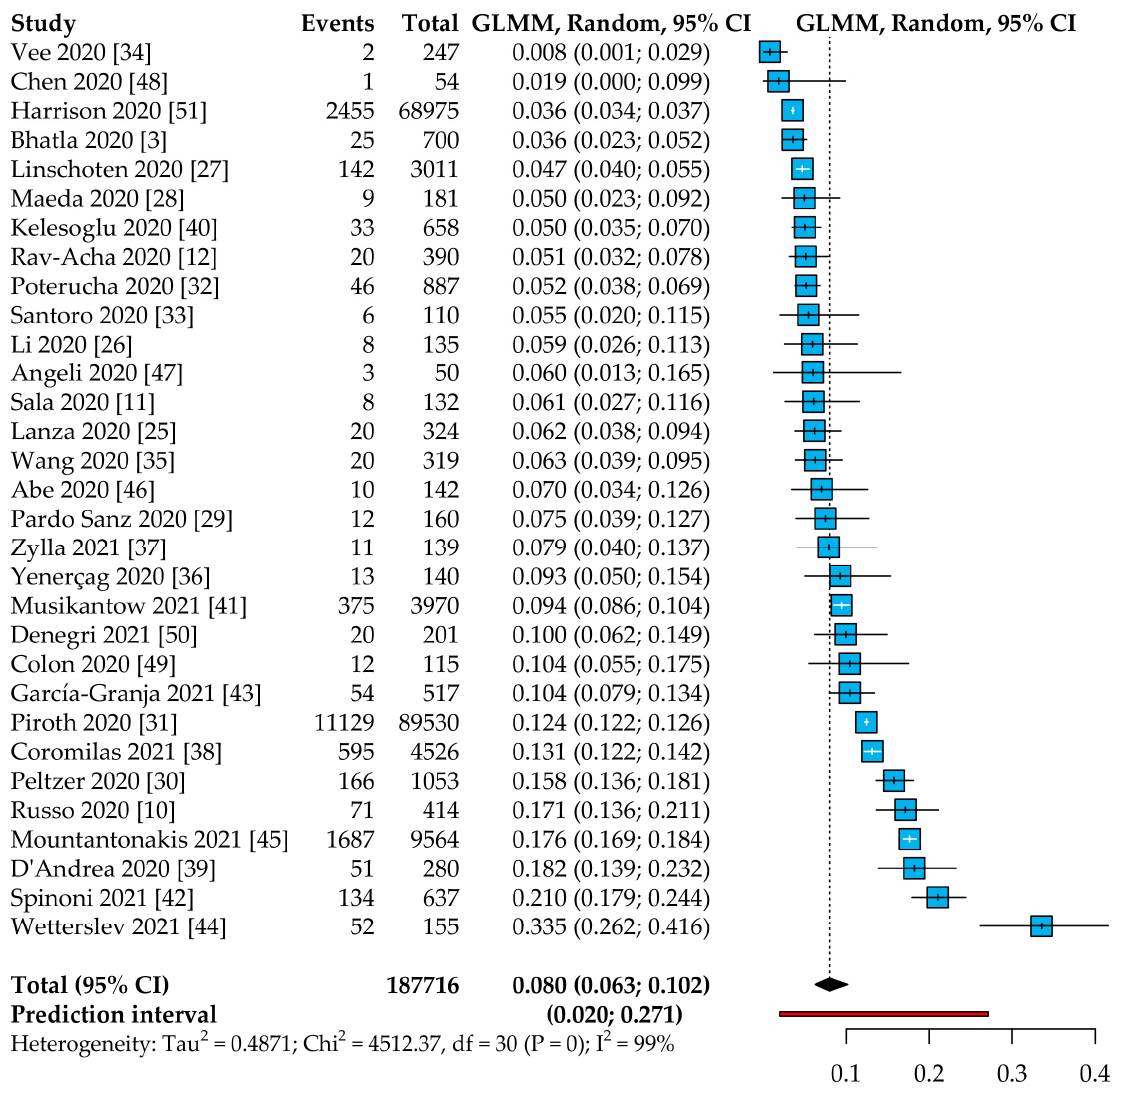
Figure 1. Pooled prevalence of AF in COVID-19 patients. Legend: CI = confidence interval; GLMM = general linear mixed model. Table 2. Univariable and multiple meta-regression * analysis for AF prevalence.